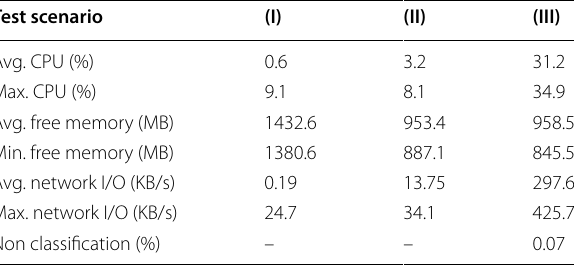
Table 2 Performance overhead evaluation methodology